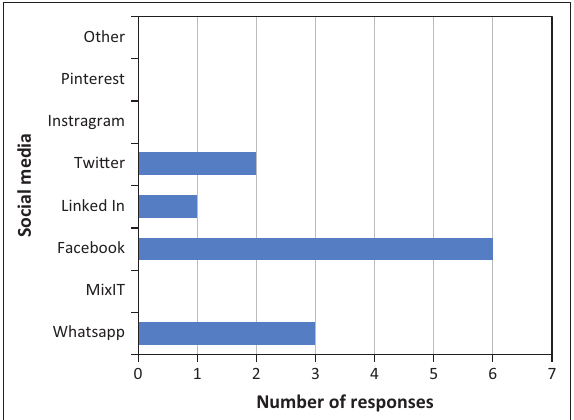
FIGURE 10: Use of social media for